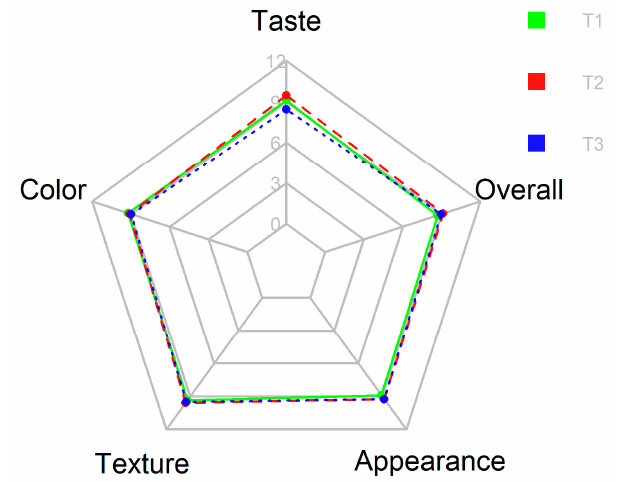
Figure 9. Radar chart for acceptability items for oyster mushroom grown on different substrates. Legend: T1—pine sawdust; T2—coconut coir; T3—waste paper.